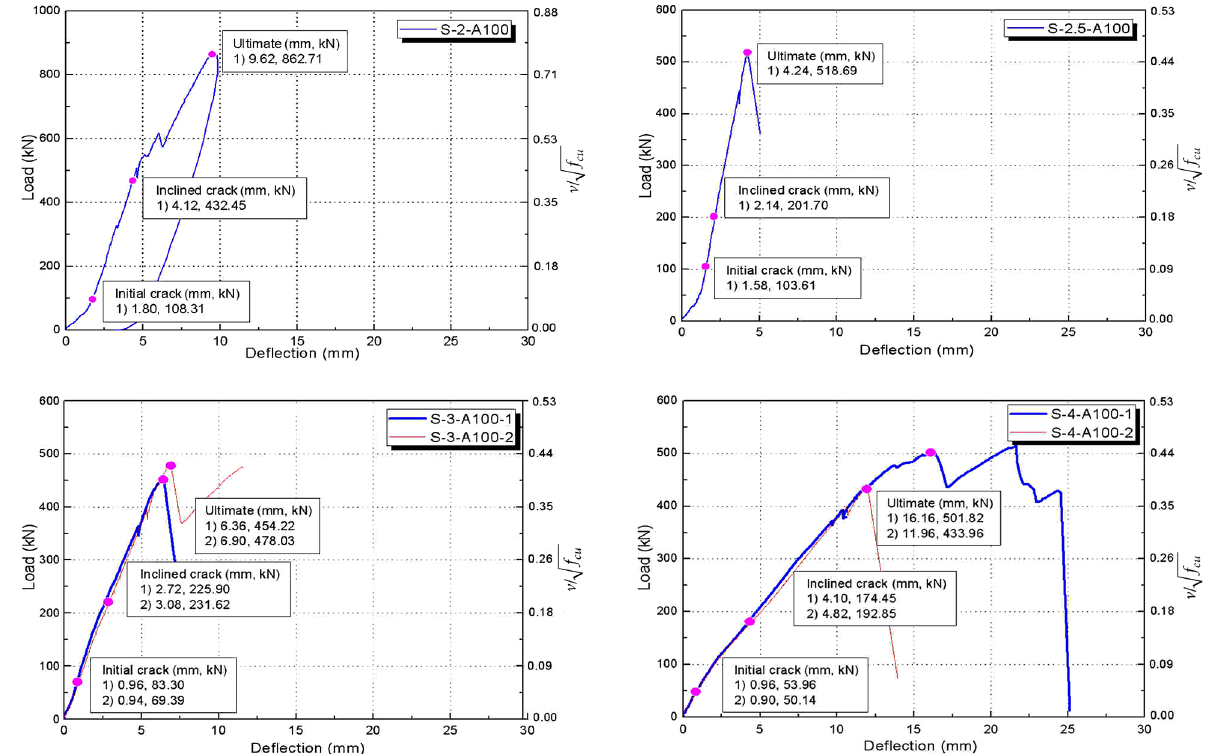
(a) Load displacement curves with various shear span-to-depth ratio ( a/d )